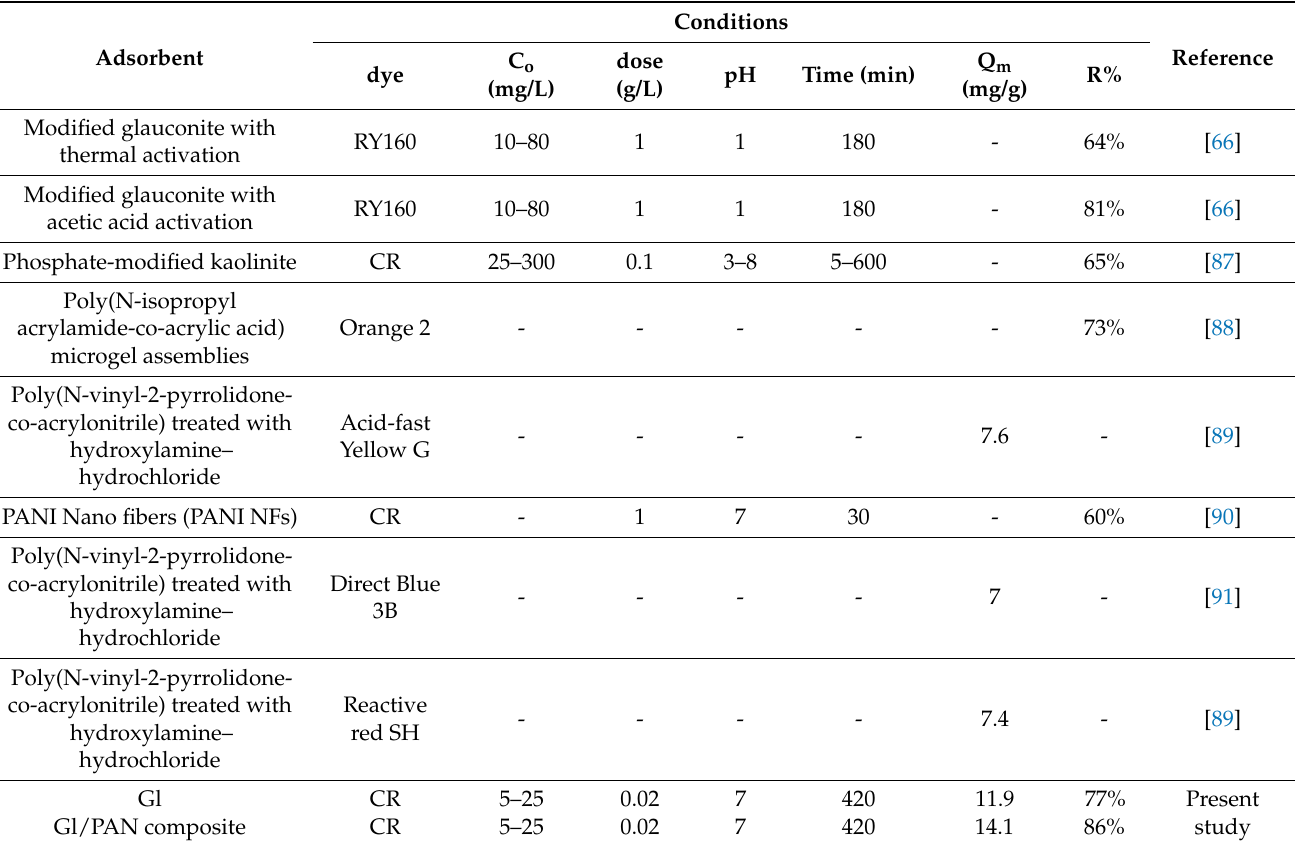
Table 5. Comparison of the optimized conditions, removal%, and adsorption capacity of different CR adsorbents relative to Gl and GL/PAN